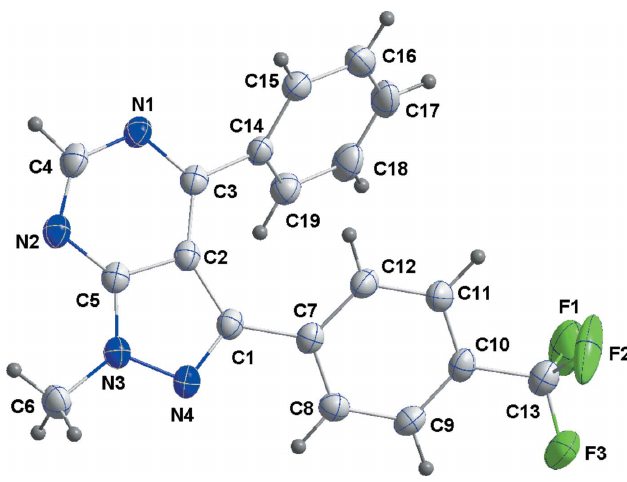
Figure 1 The title molecule with 50% probability ellipsoids.